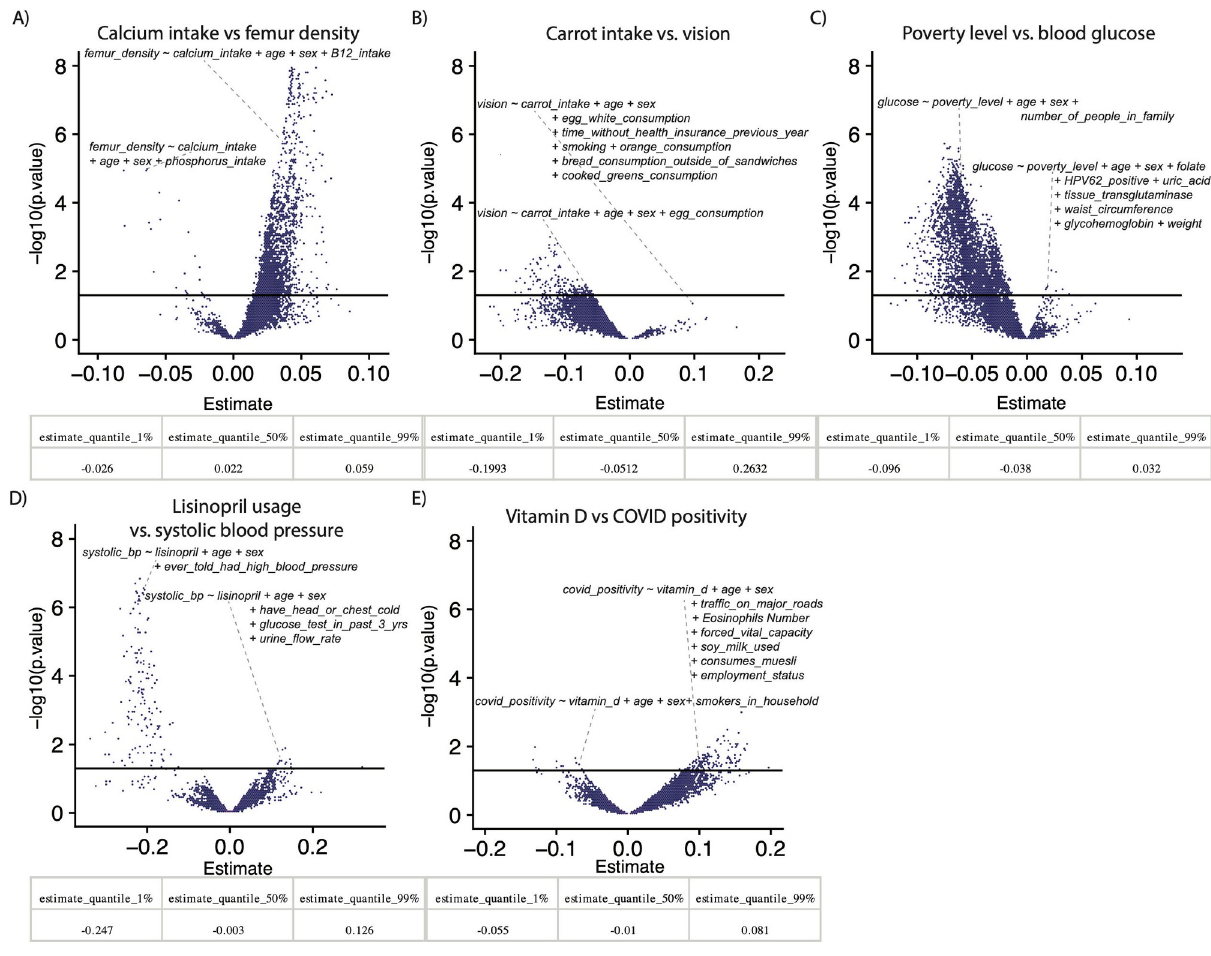
Fig 2. Examples of VoE for prominent associations. Each point in the density plots represent at least one model. x-Axes are estimate size for beta- coefficients of interest (e.g., for panel A, the coefficient on the calcium intake variable). Quantiles show the range of estimate sizes for each above relationship. The y-axis is the − log10(p.value) of that association. The solid line is nominal ( p < 0.05) significance. Data underlying these plots are available at https://figshare.com/account/home#/projects/120969 and S2 Table. VoE, vibration of effects.